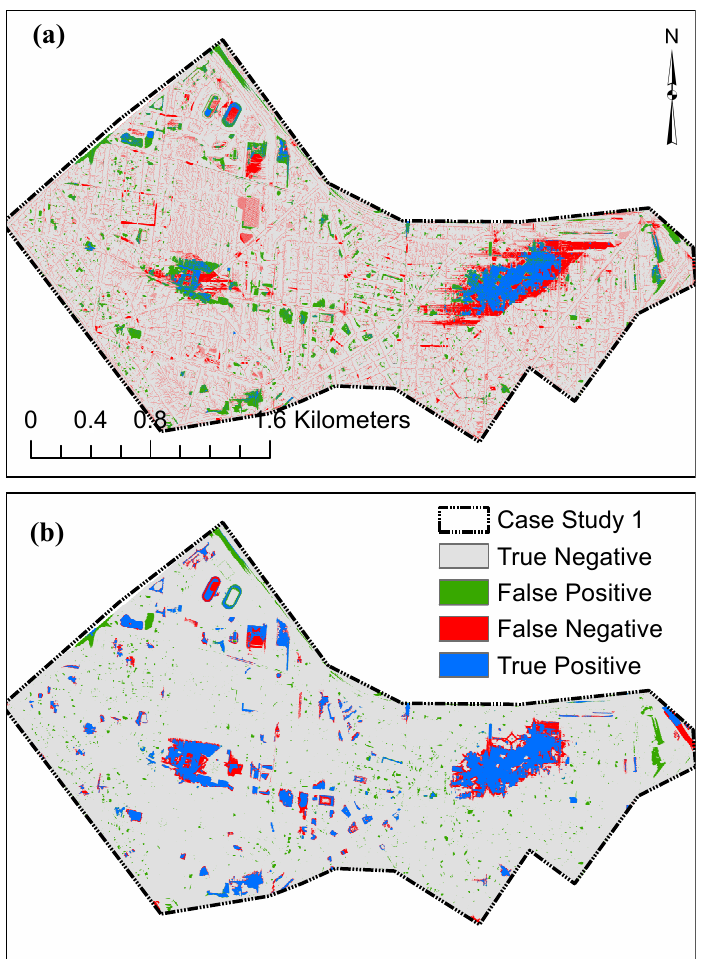
Figure 14. Comparison of the inundation extent for a 100mm precipitation event: ( a ) Comparison of TELEMAC-2D model and the TWI method inundation extents. ( b ) Comparison of TELEMAC-2D model and the FSM method inundation extents.